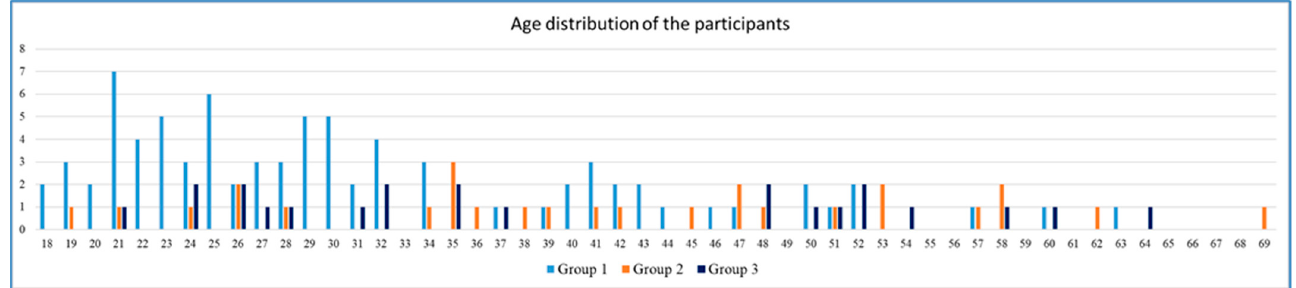
Figure 1. Age distribution of the participants assigned to Group 1, Group 2, or Group 3, according to their living arrangement. Table 1. Age, gender and living arrangements of the study participants, as well as information on the persons who com- pleted the questionnaires.